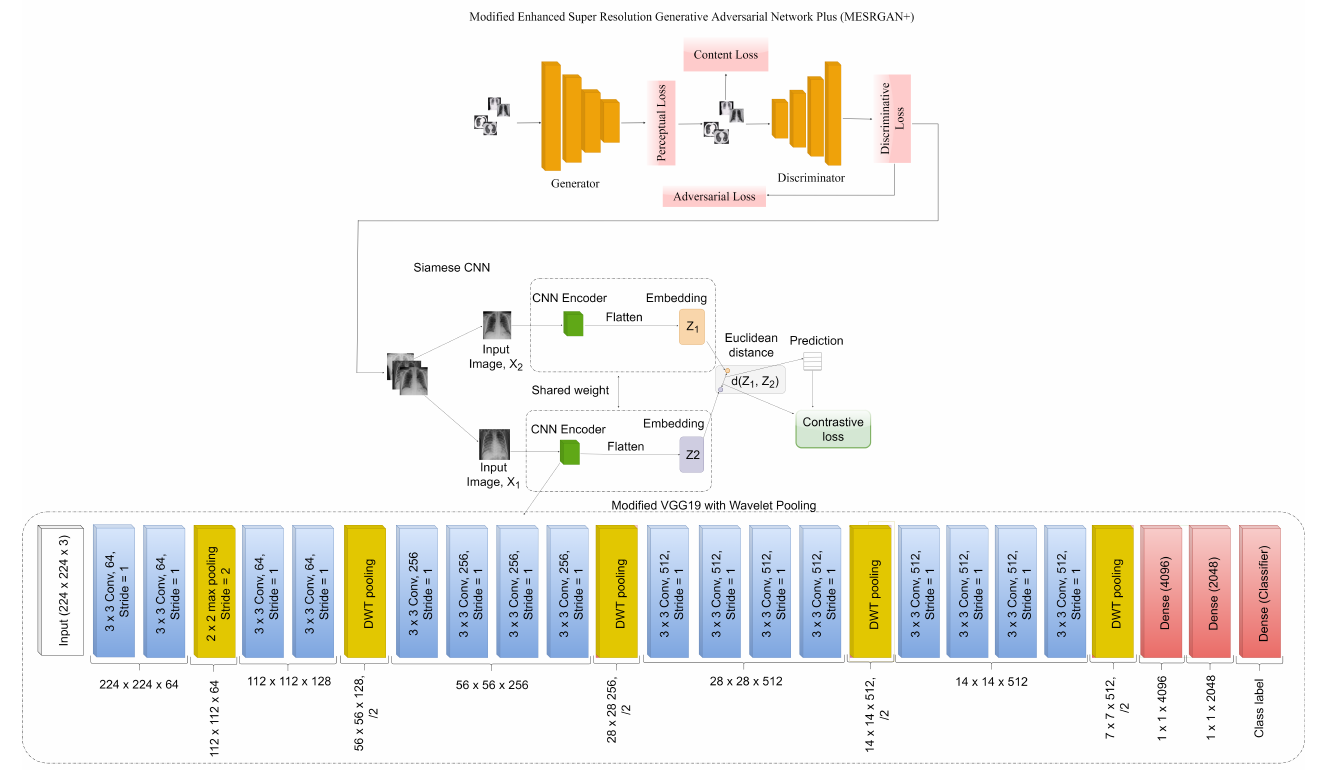
Figure 2. Our proposed modified ESRGAN+ and Siamese convolutional neural